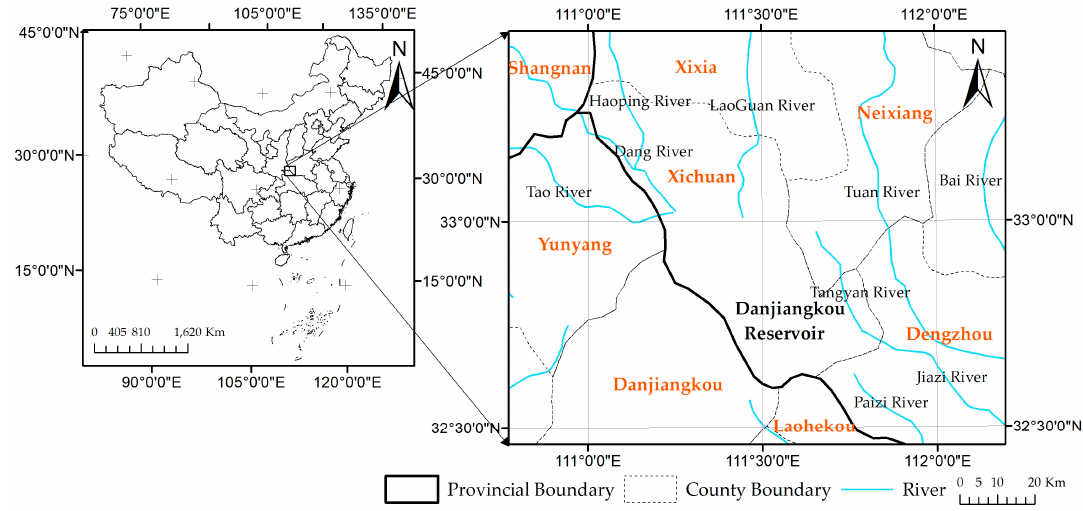
Figure 1. Regional location of the water source for the middle route of the South-to-North Water Diversion Project (SNWDP).